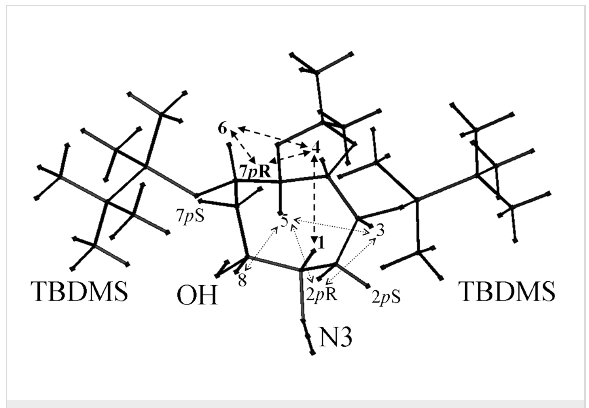
Figure 4: Schematic representation of the NOEs (indicated with arrows) found to deduce the structure of 11 . Bold arrows show the NOEs found between the protons (in bold) of the upper face of the C8 ring. Prochiral 1 H are labelled p R or p S.